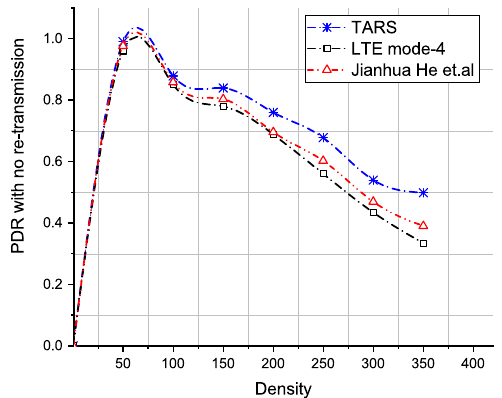
Figure 14. PDR with no retransmission versus density.